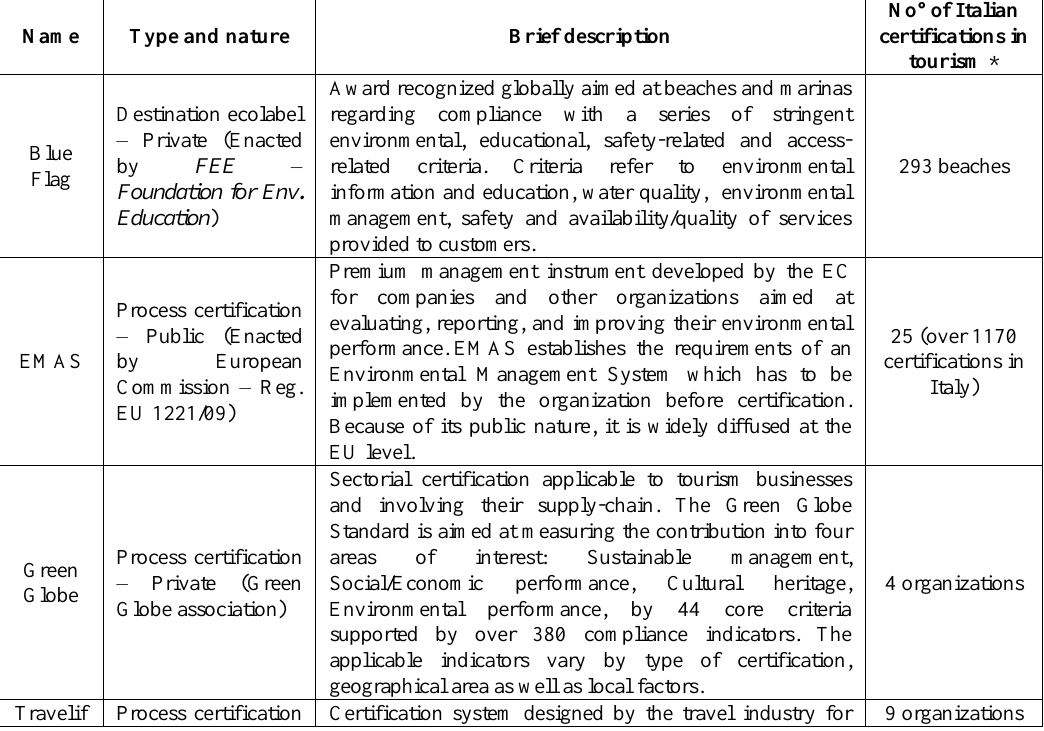
Table 1: Most Important Sustainability Certification Schemes Adopted in the Tourism